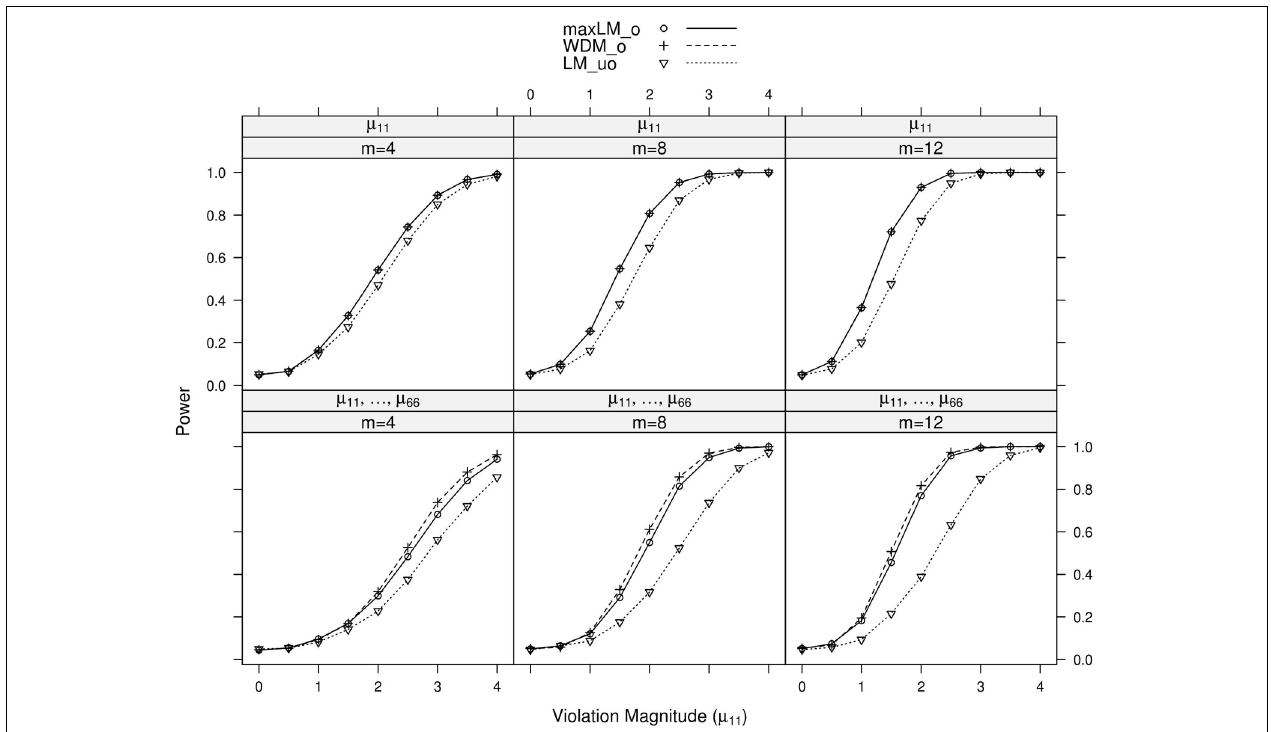
FIGURE 6 | Simulated power curves for max LM o , WDM o , and LM uo across three levels of the ordinal variable m and measurement invariance violations of 0–4 standard errors (scaled by